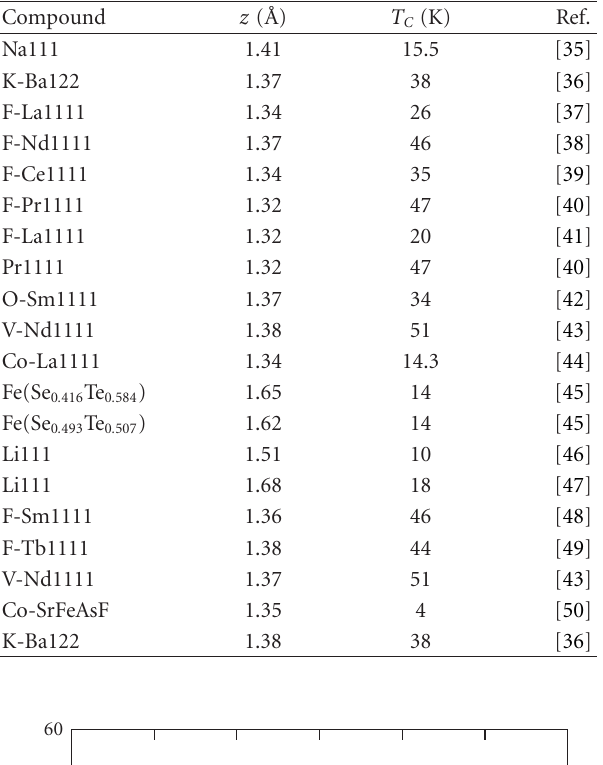
Table 1: The values of z , T C for various Fe pnictides. Na-111 means NaFeAs, K-Ba122 means K 1 − x Ba x Fe 2 As 2 , and so forth.